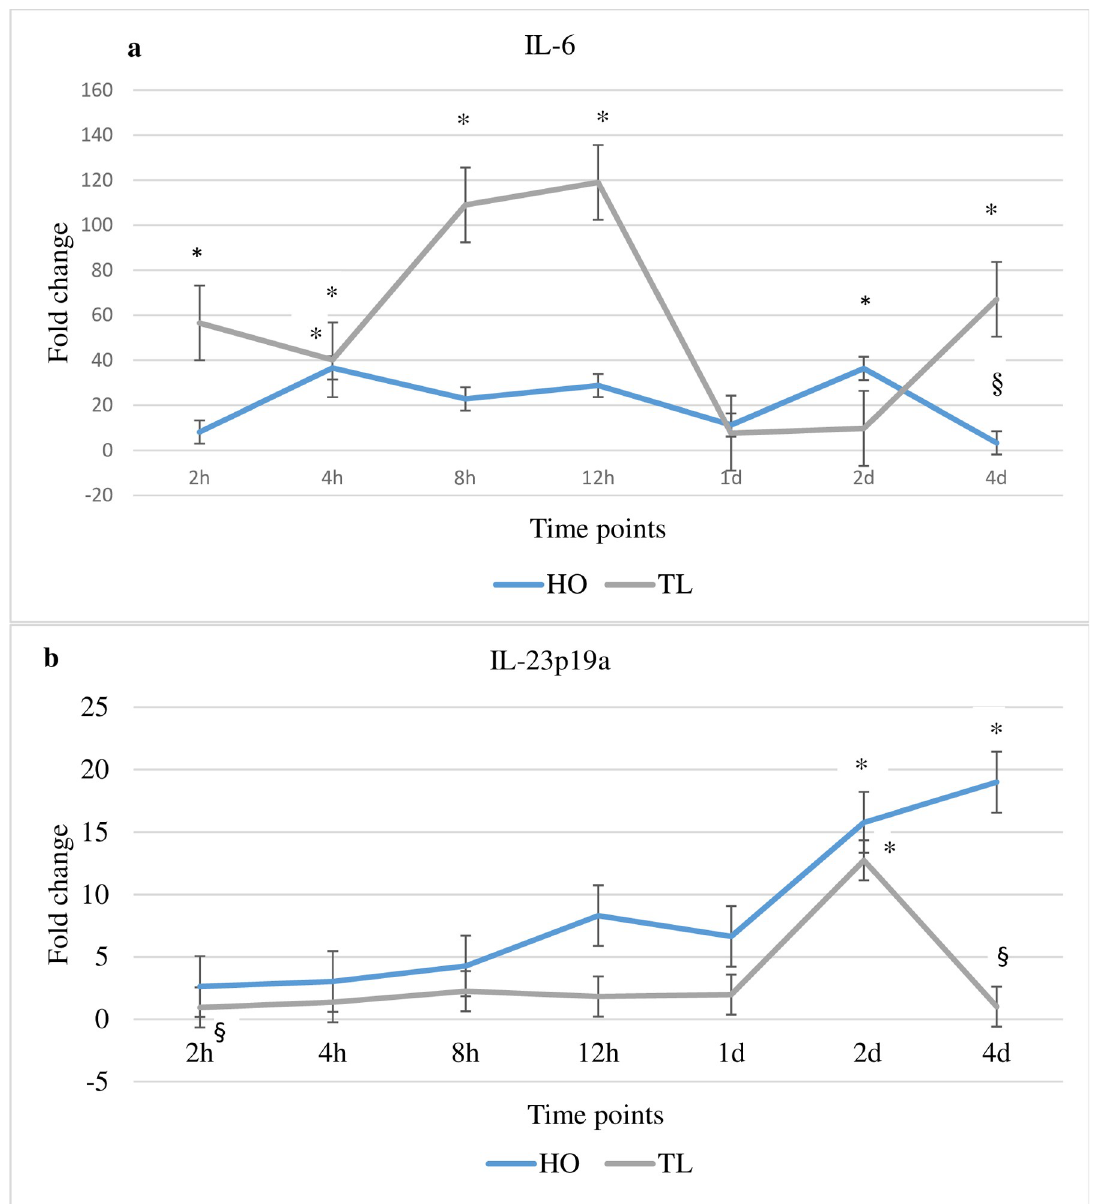
Fig 6. Transcription levels of IL-6 and IL-23p19. The figure shows the mean fold change of the genes in M . cerebralis exposed HO and TL fish. Lines are the mean fold change of IL-6 and IL-23p19 measured at different time points post exposure hpe/dpe (hours/days post exposure). All HO and TL means are presented normalized to HO and TL timed levels of control fish ± SD (n = 5). � = significantly higher and § = significantly lower to values in non-exposed fish (p < 0.05).